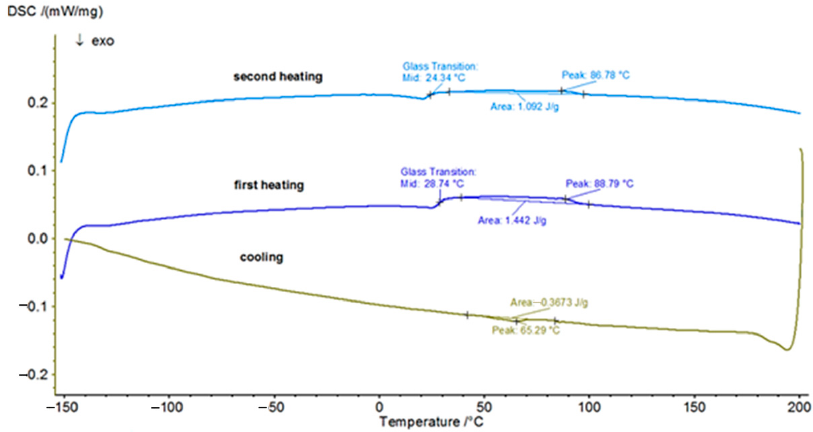
Figure 8. The DSC curves for compound 1.